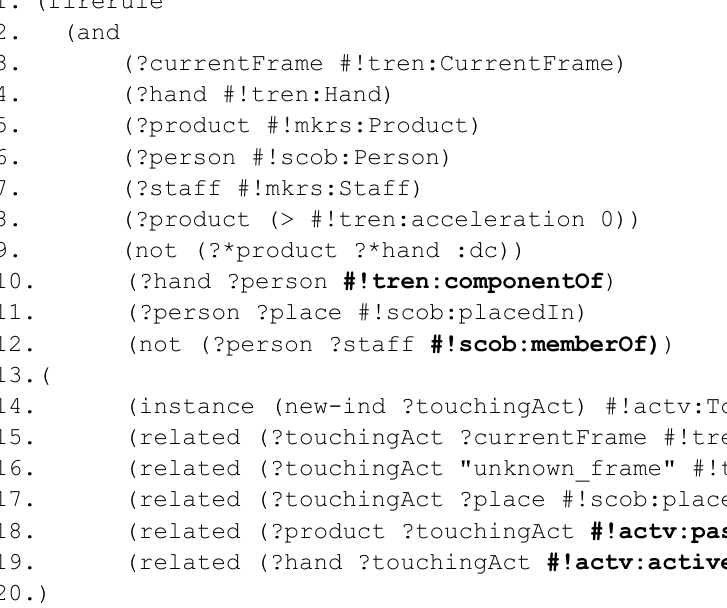
Figure 11. Rule to exemplify